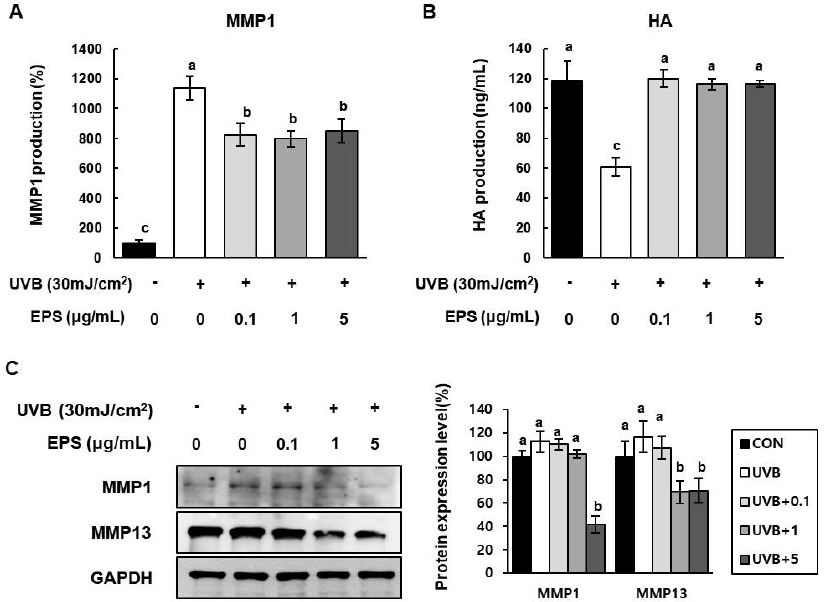
Figure 6. Effect of HY7714 EPS on protein levels of MMPs and intracellular hyaluronic acid (HA) in UVB-irradiated HS68 cells. ( A ) Relative levels of intracellular MMP1 in HS68 cells treated with HY7714 EPS were measured using an MMP1 ELISA kit. MMP1 production was amplified by pre- treatment with 100 ng/mL TNF α for 2 h. ( B ) Intracellular HA in UVB-exposed cells treated with HY7714 EPS was measured using an HA ELISA kit. ( C ) Western blotting for MMP1 and MMP13 in HS68 cells, and quantification of band density. Data are expressed as means ± SD ( n = 3), and values labeled with different letters are significantly different, p < 0.05 (a > b > c).